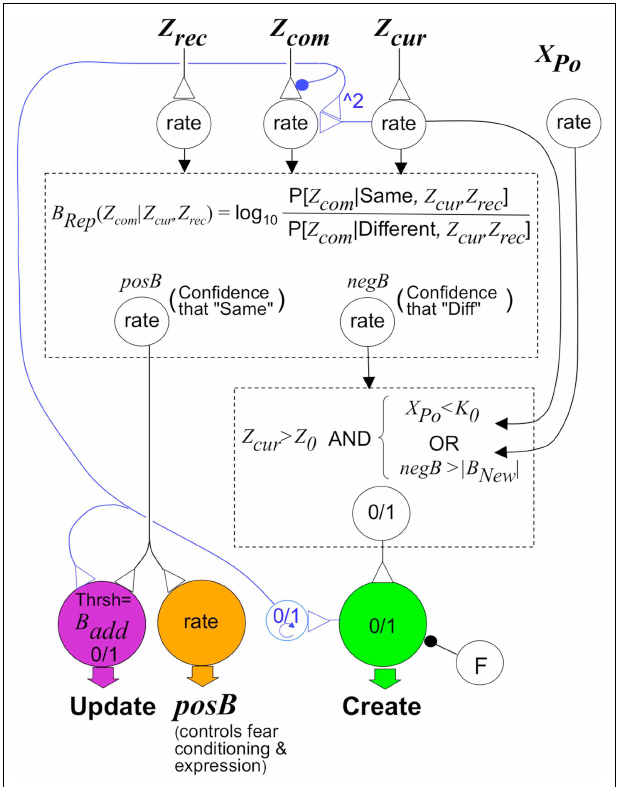
FIGURE 7 | Sketch of circuit that would implement BACON control rules. The upper dashed box represents a circuit that, like that in Figure 3B , can compute B Rep in response to input from neurons whose rate of firing signals Z cur , Z rec , and Z com . It has as output, neurons that separately convey positive and negative values of B Rep . These, along with activity of a neuron whose activity level X Po is proportional to the number of neurons active in the pre-recurrent input activity pattern of CA3 ′ ( CA 3 Ptrn o ), determine the activity of the neuromodulator-releasing neurons shown at the bottom of the figure. The neuromodulator that configures the cortical-hippocampal circuit for representation creation is released when the logical conditions in the lower dashed box are met and the creation neuron is not inhibited by neuron F. We have written the logical conditions themselves rather than a neural circuit that would implement them because this makes the logic clearer, and there are many straight-forward ways to implement these rules neurally. Inhibitory input to the Create neuron from neuron F suppresses its activity if a representation (different from the current one) for which B Rep > B pv was active earlier in the session (as explained in the section on creation and updating). Circuitry for controlling F is provided in the Supplementary Material (Topic D). The neuromodulator that configures the cortical-hippocampal circuit for updating is released when posB > B add . However, if a new representation has been created, the neuromodulator must continue to be released until the automaton leaves the context. This is mediated by a binary (“0/1”) working memory neuron that becomes active when representation creation occurs and remains so until BACON leaves the context. The binary neuron also reconfigures input to a neuron innervated by Z com so that (as discussed in the text section on Conditionability) it will reflect Expected Z com instead of Z com itself. This is done by inhibiting transmitter release from the Z com neuron and activating an input from Z cur that causes the target cell to respond as the square of Z cur ; this in-effect computes the expected value of Z com given that Z rec equals Z cur when the automaton is updating representations. Control of fear conditioning and expression is mediated by a neuromodulator that is released in proportion to the posB signal. Its effect on conditioning and fear expression are as described in the